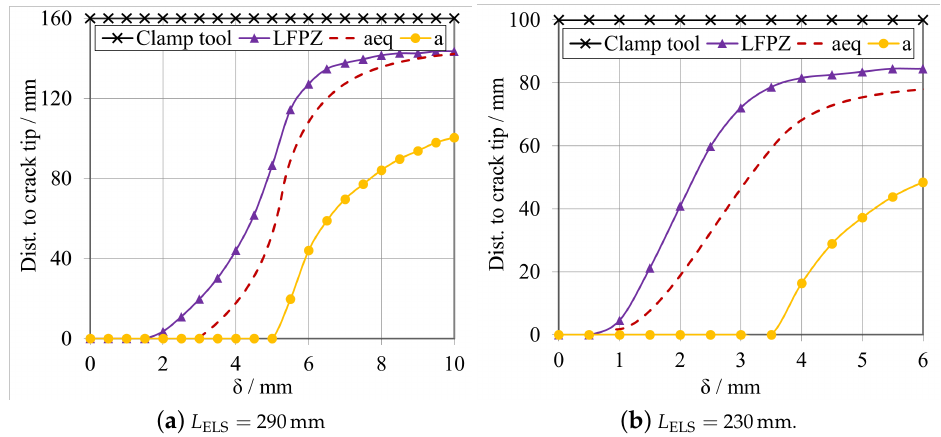
Figure 17. Study of L FPZ , a eq and a , for the tough adhesive, with a 0 ELS =